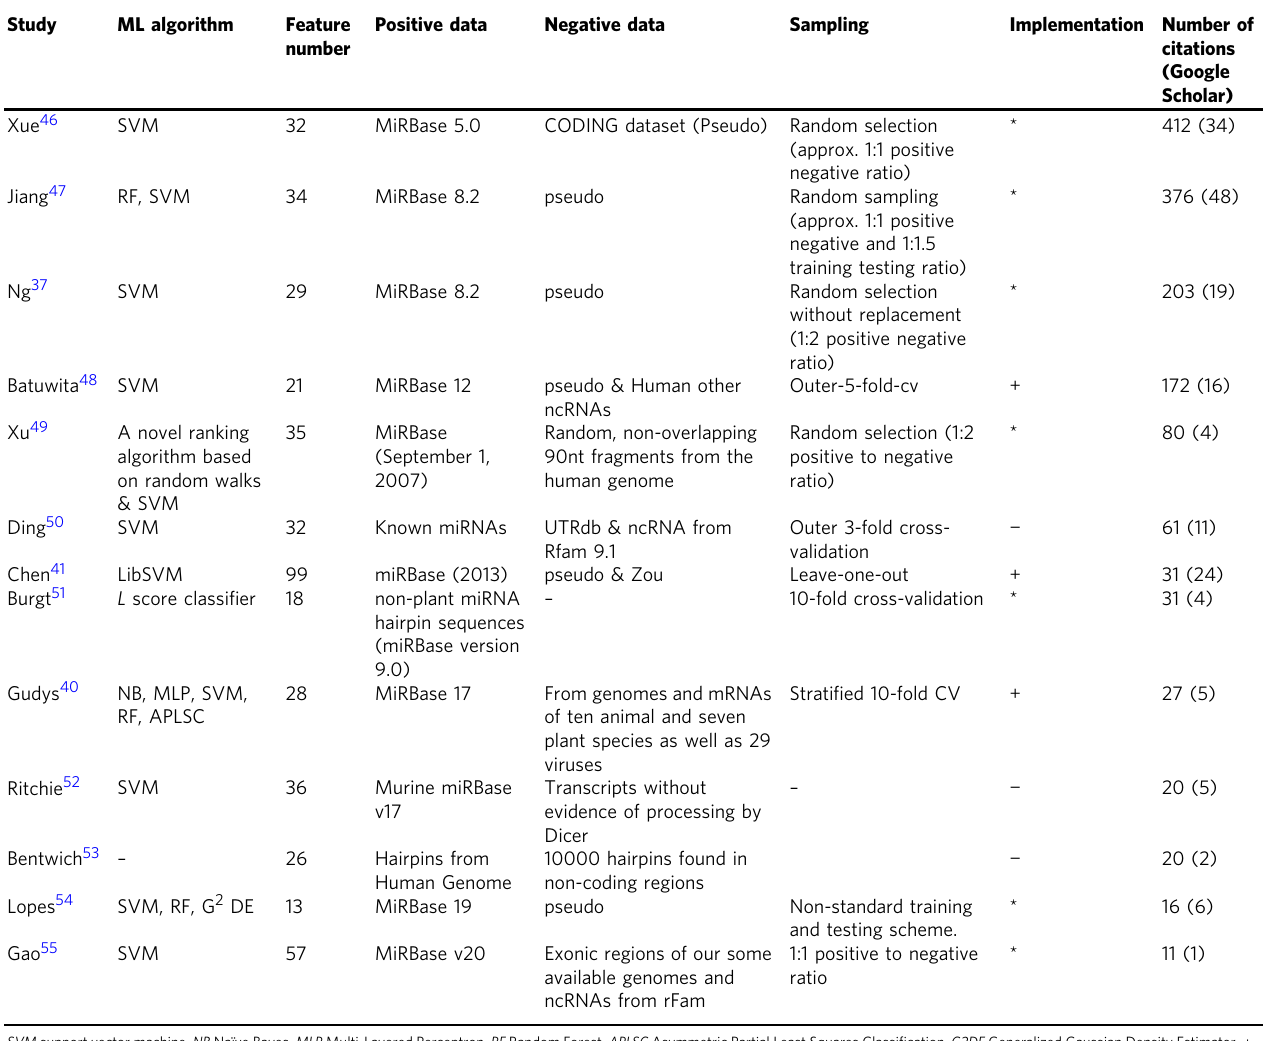
Table 1 Available pre-miRNA detection tools Study ML